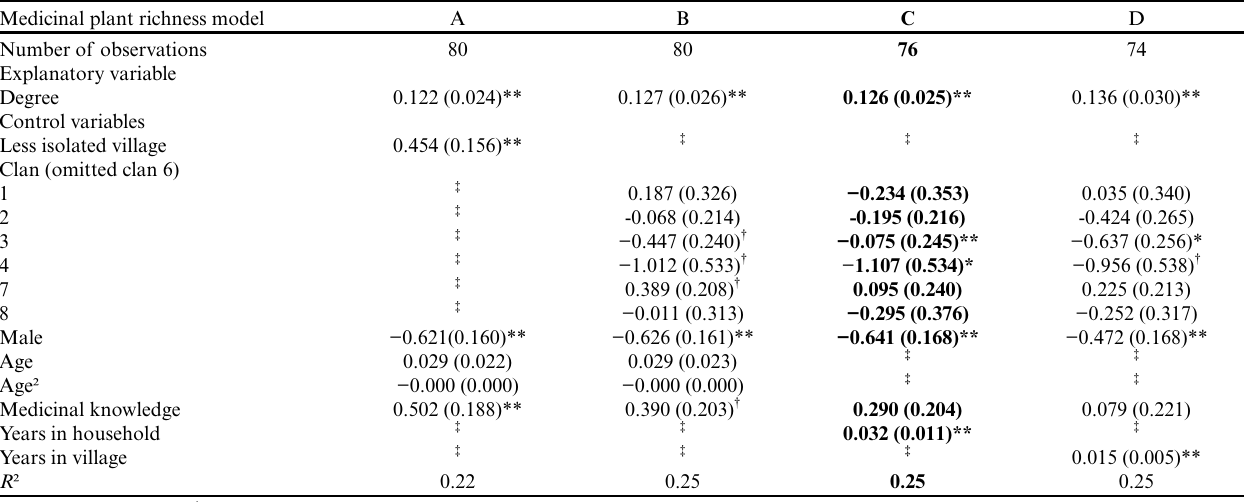
Table 3. Poisson multivariable regressions between informants’ medicinal plant richness in homegardens and individual centrality measures. Robust standard errors are given in parentheses. Model C (bold) was used in robustness analysis. See Table 2 for variable